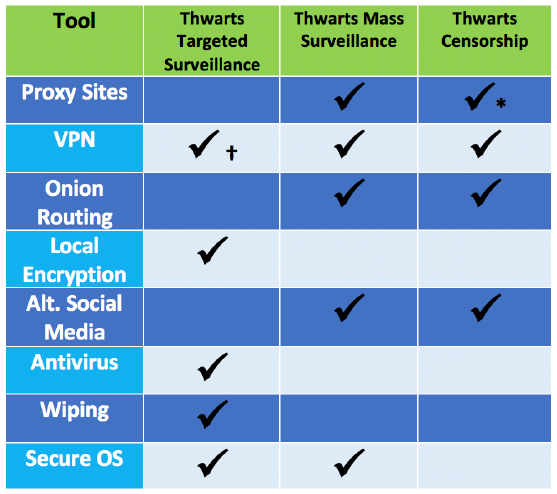
Figure 2. Table showing how a defensive tool corresponds with surveillance or censorship.